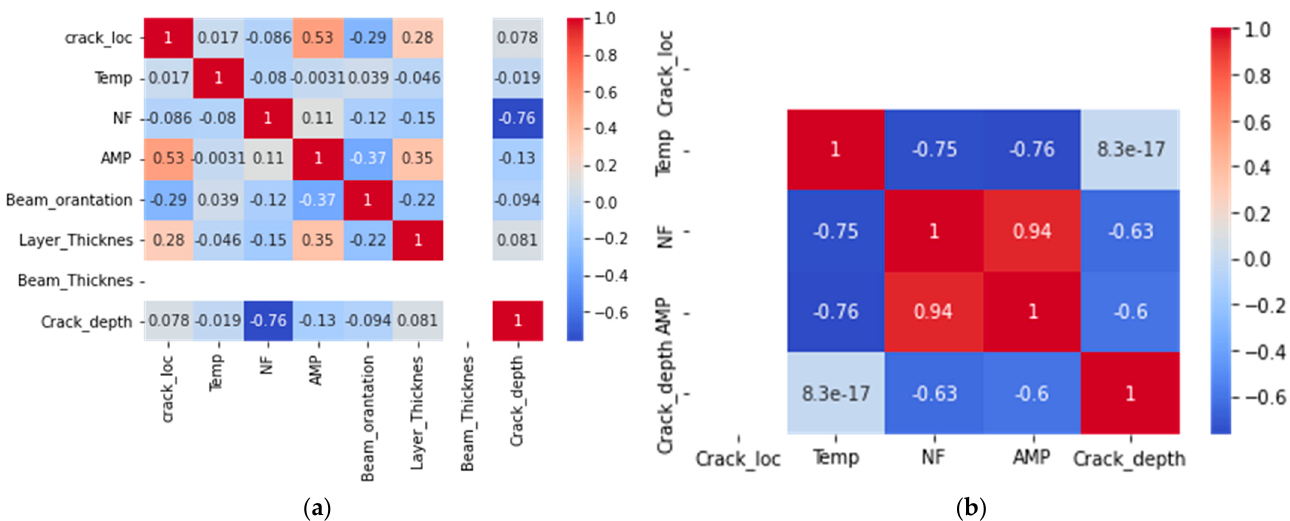
Figure 10. The heatmap indicates the effect of the features on each other in ( a ) ABS, ( b ) aluminum. The prediction accuracy of the selected machine learning models was measured using indicates a better performing model, as it indicates a smaller average prediction error.